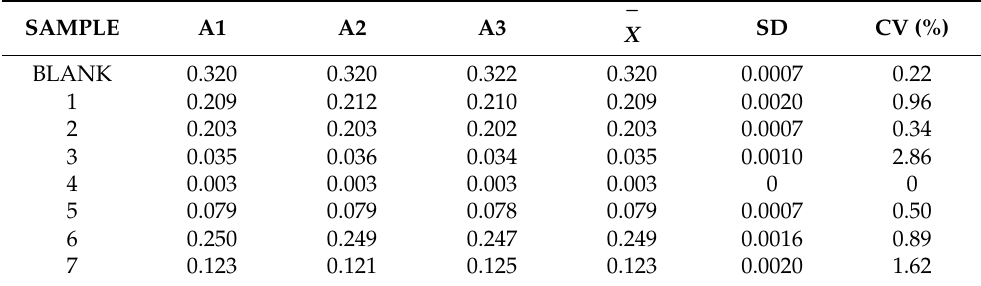
Table 13. Absorbances obtained for hydrophilic extracts of cream samples (ABTS method).